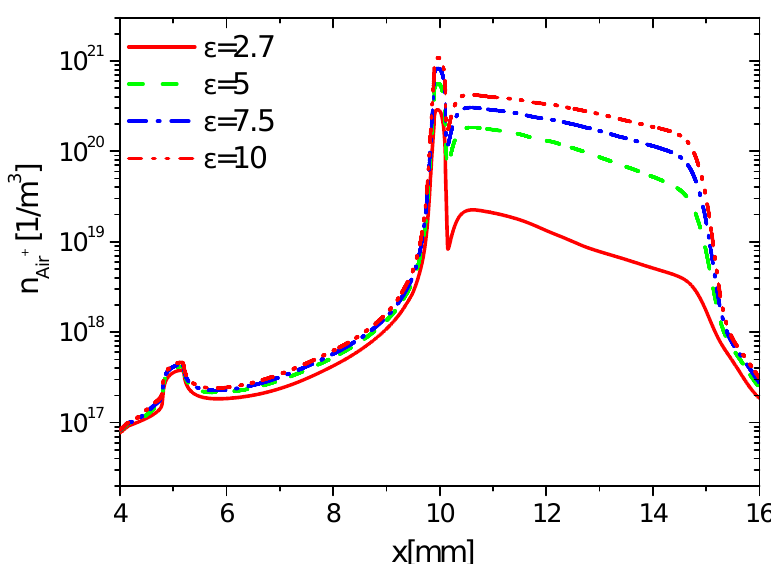
Figure 10. Effect of ε on the distributions of n Air + at 15 ns in the rise phase.